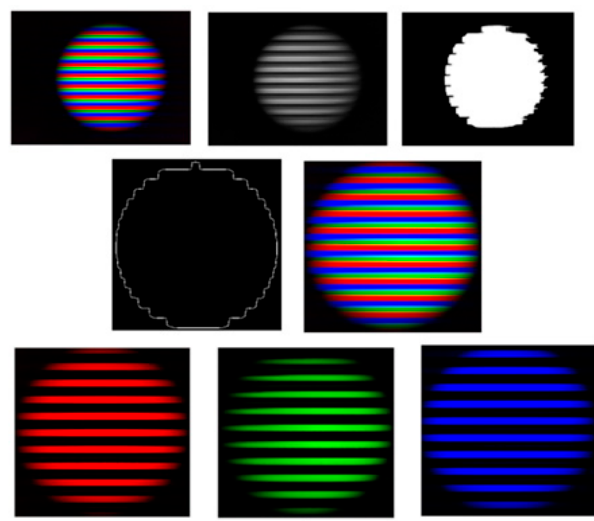
Figure 9. Image preprocessing.